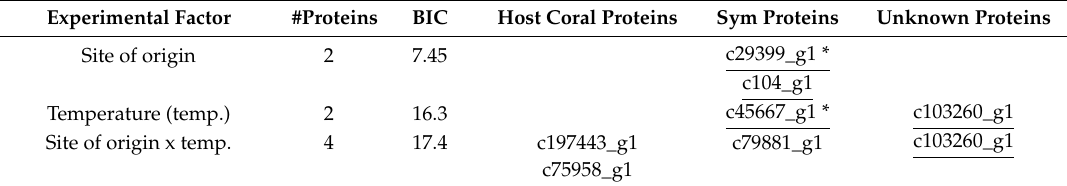
Table 3. Results of stepwise regression (SRA) for identifying “proteins of interest” (POIs). Putative di ff erentially concentrated proteins identified by response screening analysis have been denoted by asterisks(*); theotherfiveproteinsinsteadrepresentPOIs(withthoseidentifiedbystepwisediscriminant analysis underlined). Please note that no bacterial or viral proteins featured in any of the SRA models. Symbiodiniaceae (Sym) proteins: c104_g1 = “in between ring fingers” protein (protein-protein interactions) and c79881_g1 = peridinin chlorophyll a-binding protein (photosynthesis). Host coral proteins: c197443_g1 = Pao retrotransposon peptidase (DNA modification) and c75958_g1 = zinc finger CCCH domain-containing protein 3-like (mRNA export). All other proteins could either not be identified (c103260_g1) or are described in Figure 3. BIC = Bayesian information